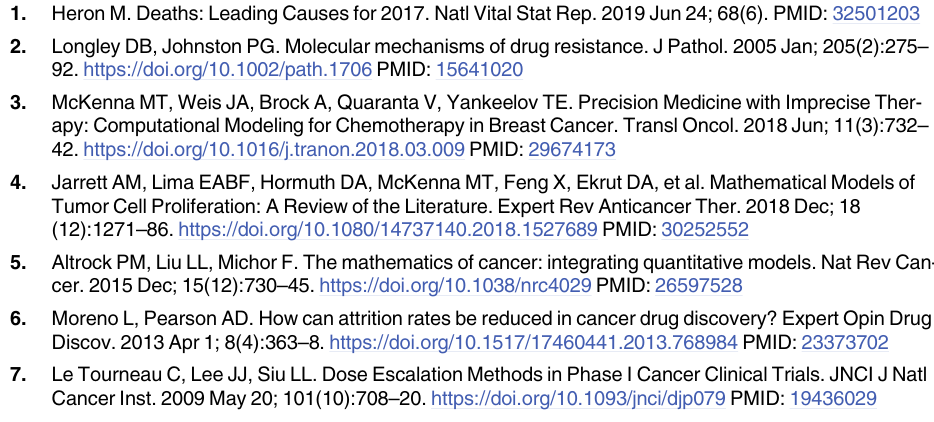
simulated data sets. Table B . Parameter distributions for simulated data sets. Figure A . Model performance on data with no proliferation delay. Figure B . Model performance on data with a proliferation delay. Figure C . Model performance with fixed vs. calibrated carrying capacity. Figure D . Model performance on matched and mismatched death delay assumptions. Table C . Model performance summarized via PCC. Text B . Constraining the model calibra- tion. Text C . Structure of model preferences. Figure E . Selection of model 1 over model 2. Figure F . Selection of model 1 over model 3. Text D . Details of Model Validation Results. Table D . Leave-one-out validation of model 1 calibration results. Text E . Processing Defini- tion Optimization in the Incucyte